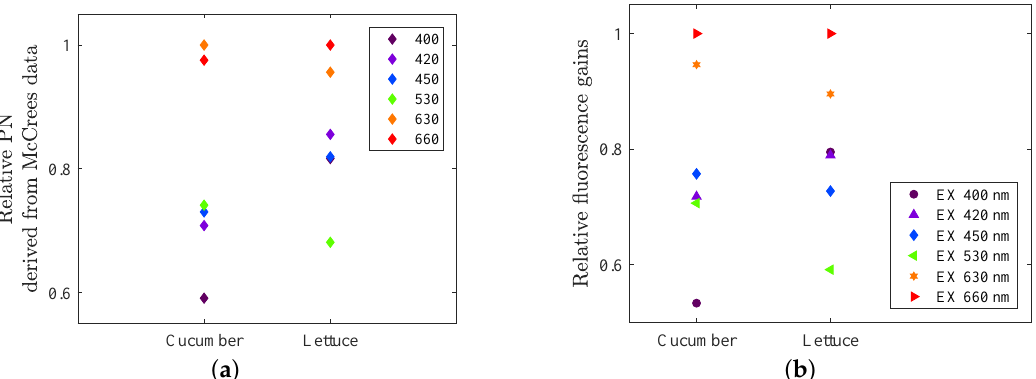
Figure 12. ( a ) Relative PN gain of each LED colour for cucumber and lettuce, calculated from data from McCree. ( b ) Experimentally derived fluorescence gains at background light intensity 160µmolm − 2 s − 1 (set